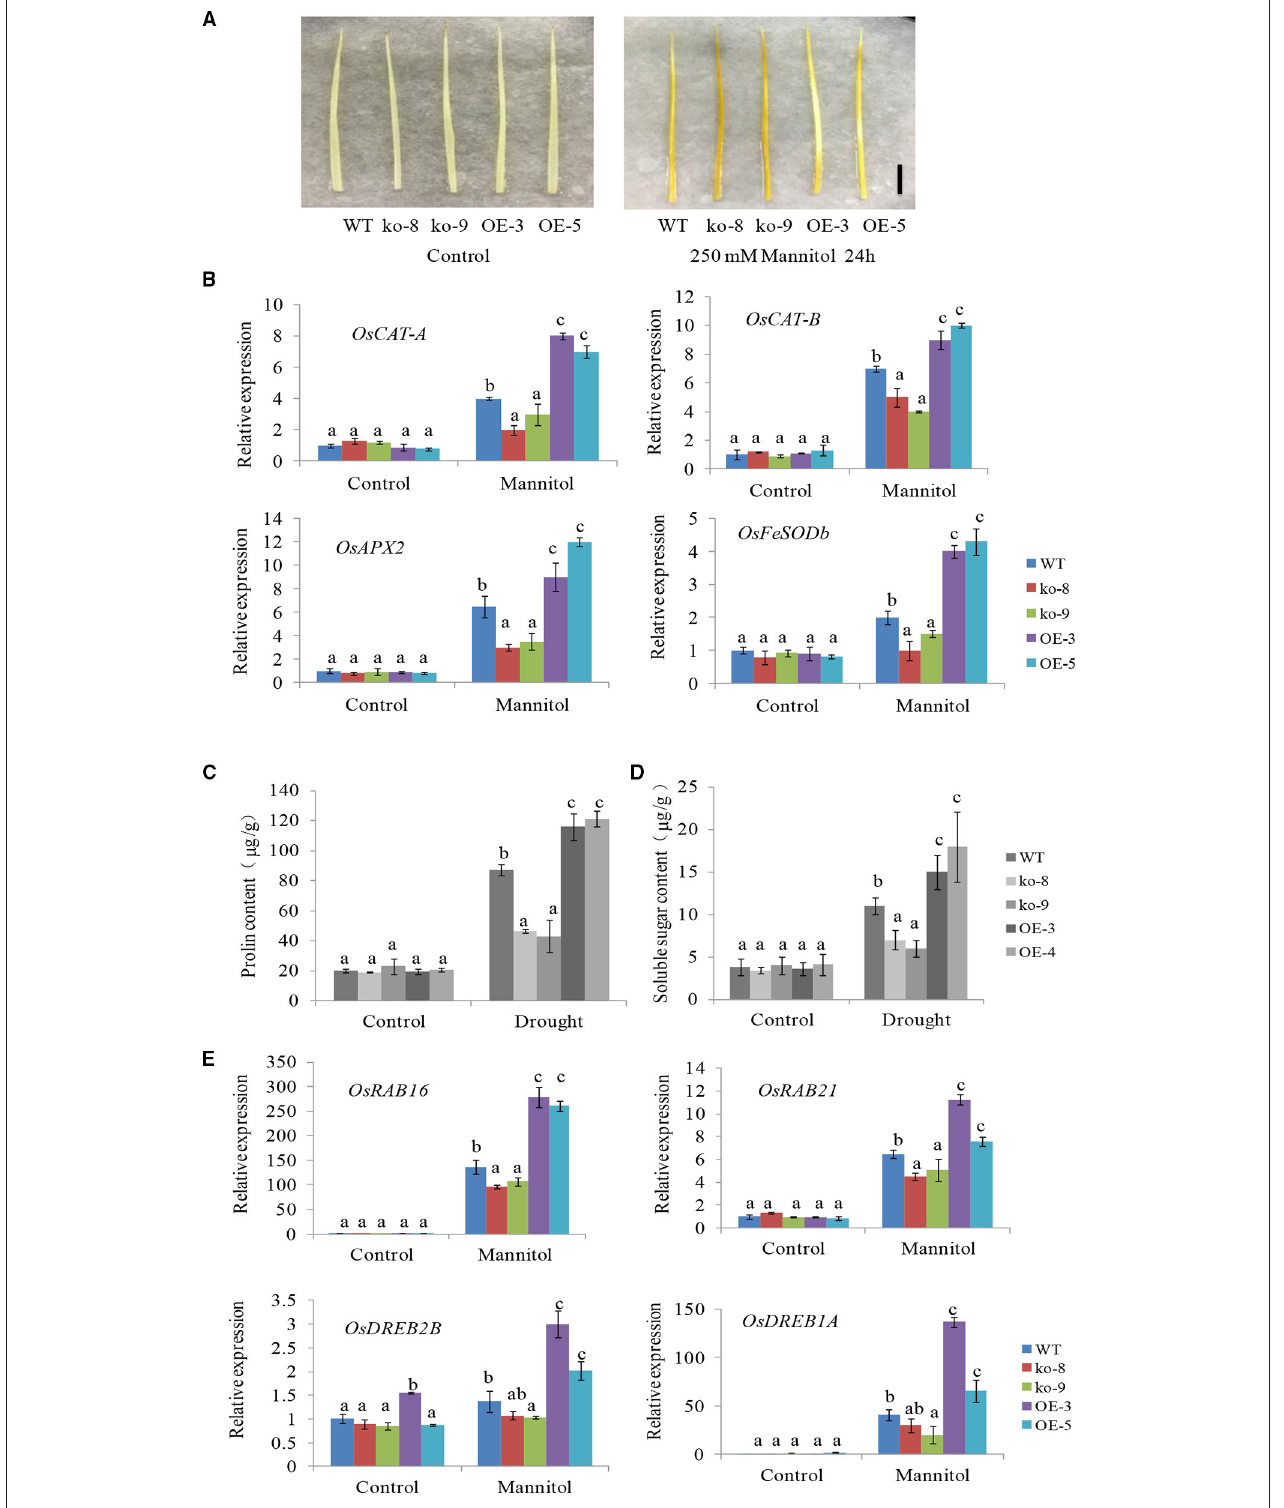
FIGURE 5 | Accumulation of hydrogen peroxide (H 2 O 2) and the expression levels of reactive oxygen species (ROS) scavenging genes and drought stress response genes in UGT85E1 transgenic lines. (A) DAB staining of UGT85E1 transgenic lines under control and mannitol treatments, scale bar = 2cm; (B) Transcription levels of ROS scavenging enzyme genes in UGT85E1 transgenic lines under normal and drought stress conditions; (C,D) Proline and soluble sugar contents in rice leaf tissues